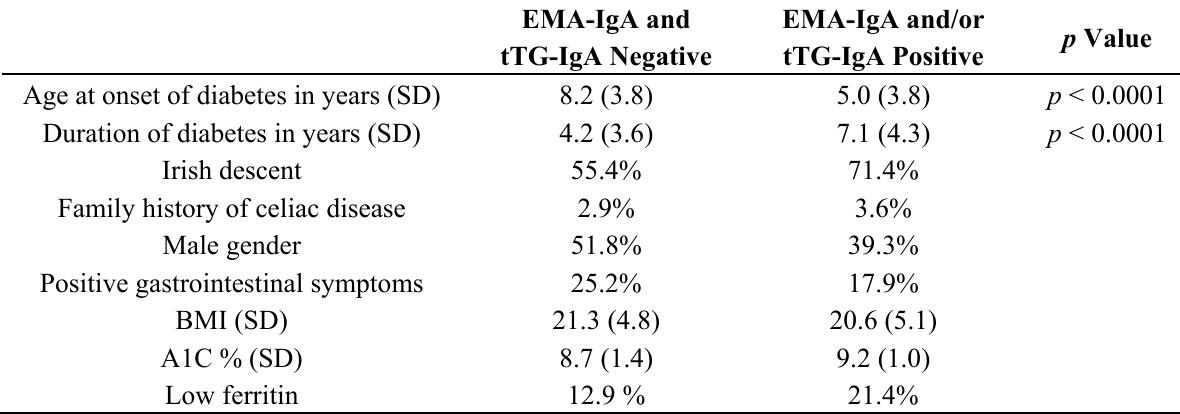
(BMI (body mass index) = weight (kg)/[height (m)] 2 ; A1C = hemoglobin A1C; SD = standard